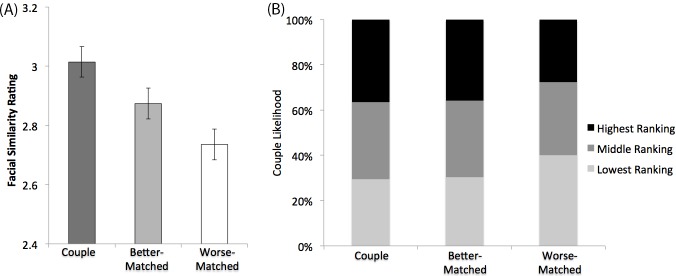
Results of Experiments 2 and 3.(A) Ratings of facial similarity in Experiment 2. The error bars represent the 95% confidence intervals of the main effect of face type. (B) Percentages of the highest, middle and lowest ranking in terms of the likelihood of belonging to a couple for the three types of face pairs in Experiment 3.